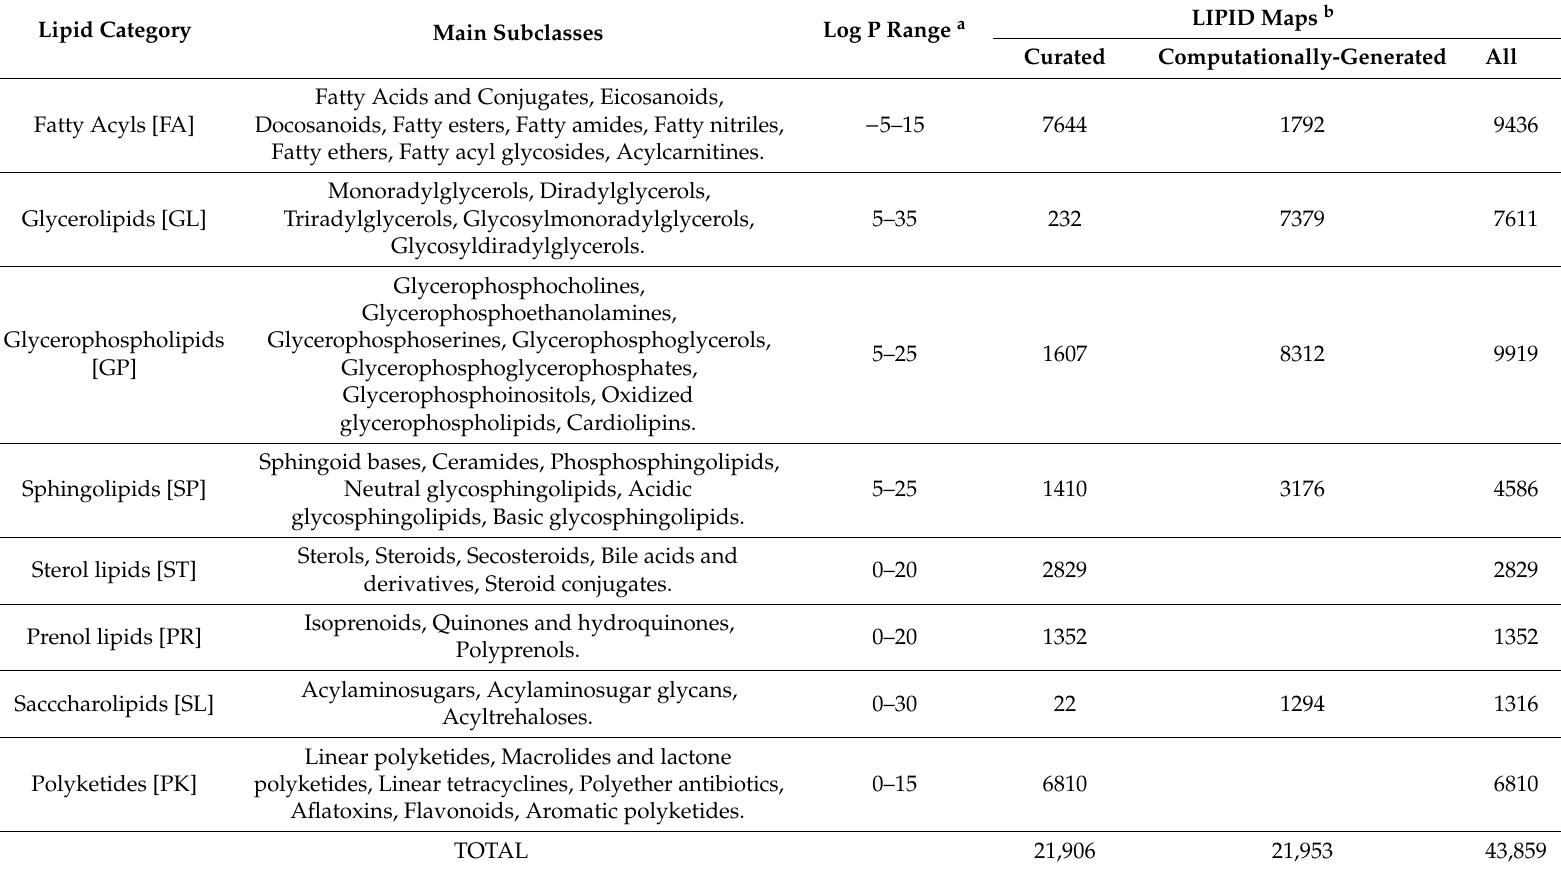
Table 1. Number of lipids structures per representative lipid